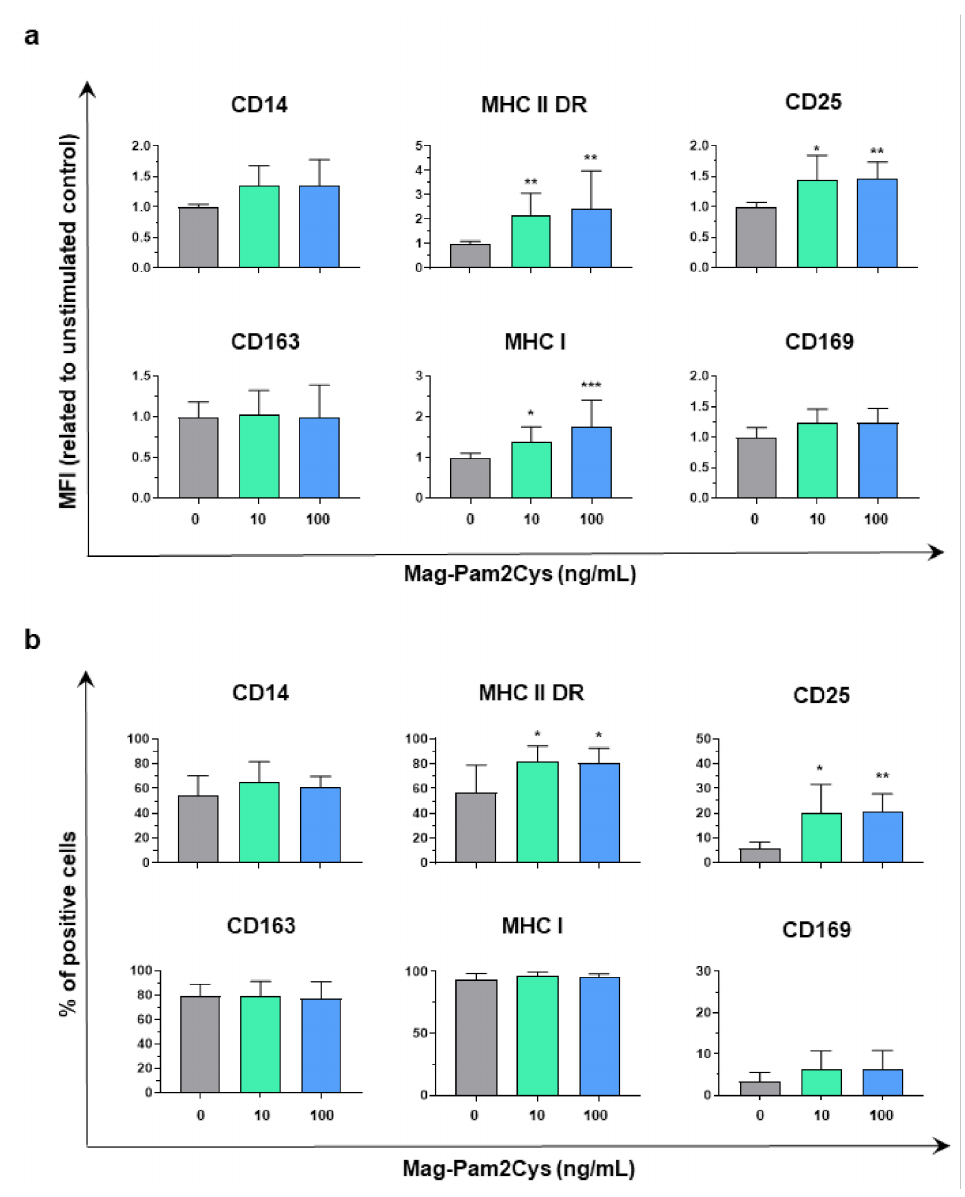
Figure 2. Effect of Mag-Pam2Cys on moM Φ surface marker expressions. Then, 24 h post-stimulation with scalar doses of Mag-Pam2Cys (10 or 100 ng/mL), surface expression of CD14, MHC II DR, CD25, CD163, MHC I, and CD169 were assessed by flow cytometry. In Panel ( a ), mean fluorescence intensity (MFI) data are presented as fold-change relative to the untreated control (moM Φ ). In Panel ( b ), percentages of positive cells are shown. For both Panels, mean data and SD from four independent experiment using different blood donor pigs are displayed. Values of Mag-Pam2Cys- treated samples were compared to the untreated control (moM Φ ) using a one-way ANOVA followed by a Dunnett’s multiple comparison test. *** p < 0.001, ** p < 0.01, * p <